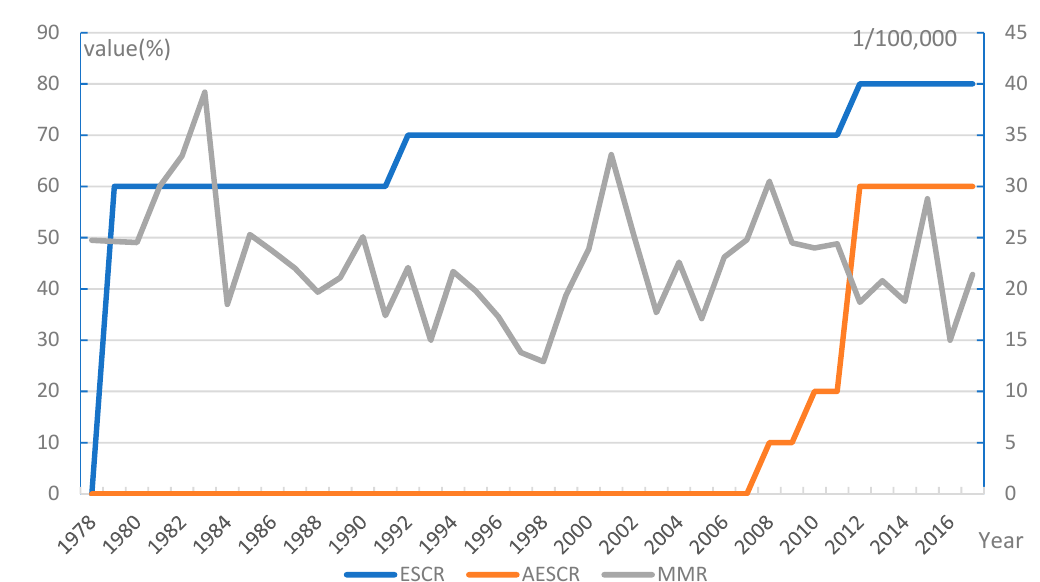
Figure 2. Trends of MMR, ESCR, and AESCR in NYC. NYC has introduced policies on 8 categories of essential WHSs (i.e., except pre-marital healthcare and menopause care services). Infertility intervention and intrapartum care services have no corresponding assessment indicators or assessment criteria in public policy documents. MMR: Maternal mortality ratio; ESCR: The essential maternal healthcare service coverage rate; AESCR: The assessable essential healthcare service coverage rate; NYC: New York City; WHSs: Women’s healthcare services.